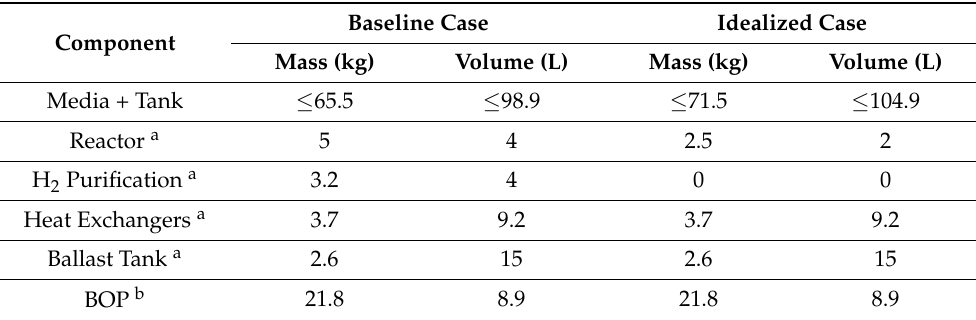
Table 5. Baseline and idealized system component masses and volumes for fluid-phase chemical hydrogen storage media used. Reproduced from [2]. Baseline Case Idealized Component